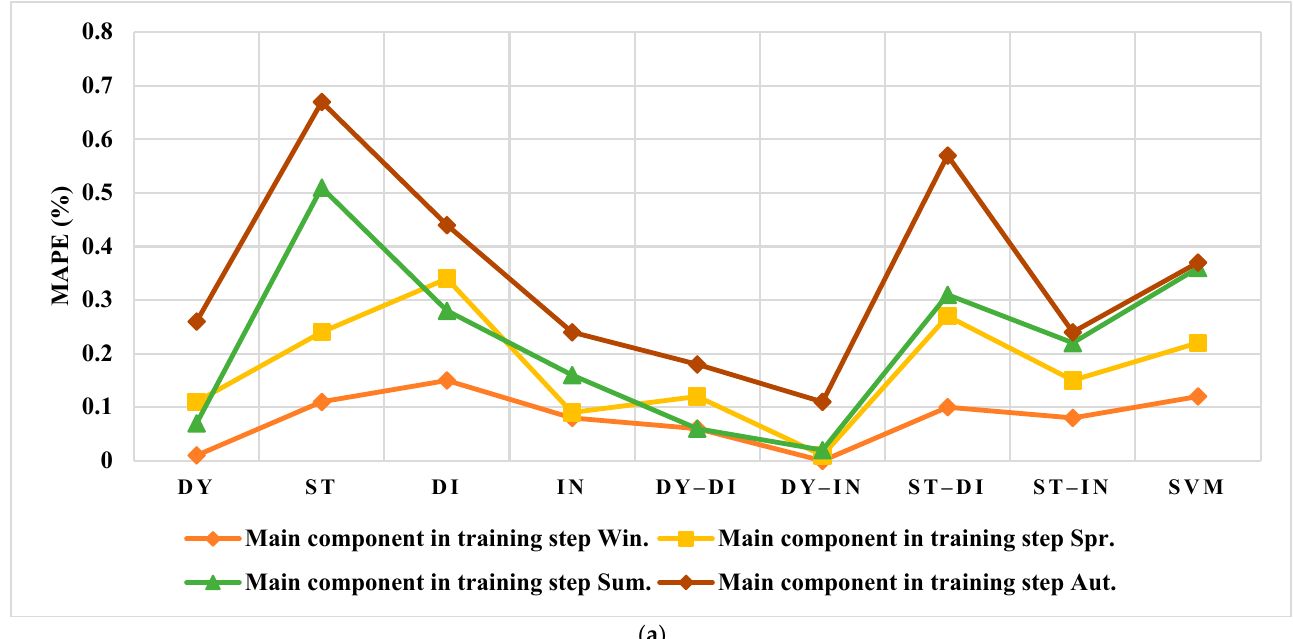
Main component in training step Spr. Main component in training step Aut.